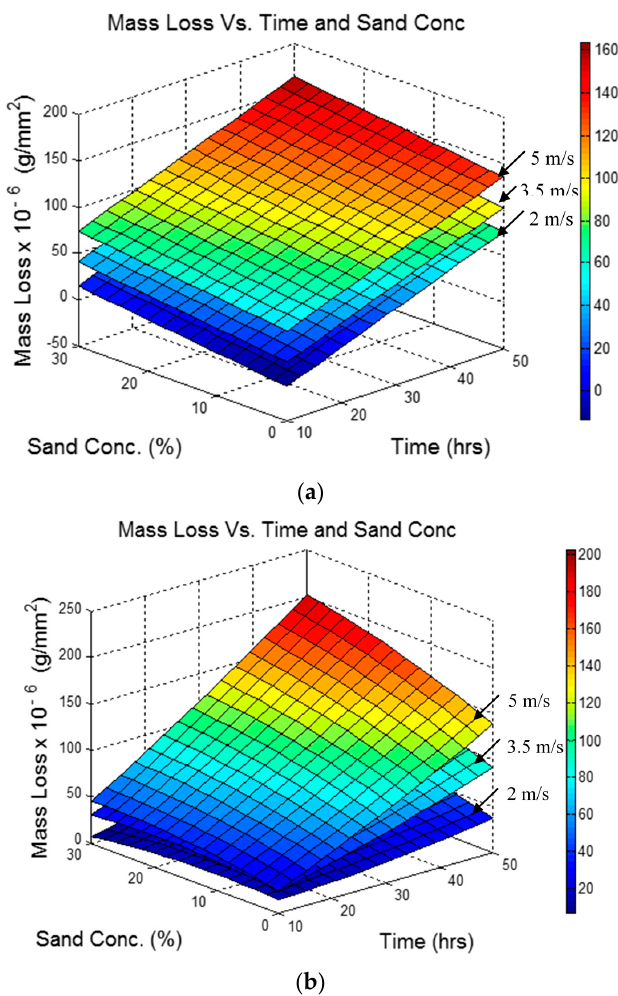
Figure 8. Mass loss versus time and sand concentration for constant velocities ( v = 2 m/s, 3.5 m/s, and 5 m/s); ( a ) First-order polynomial; ( b ) Second-order polynomial.